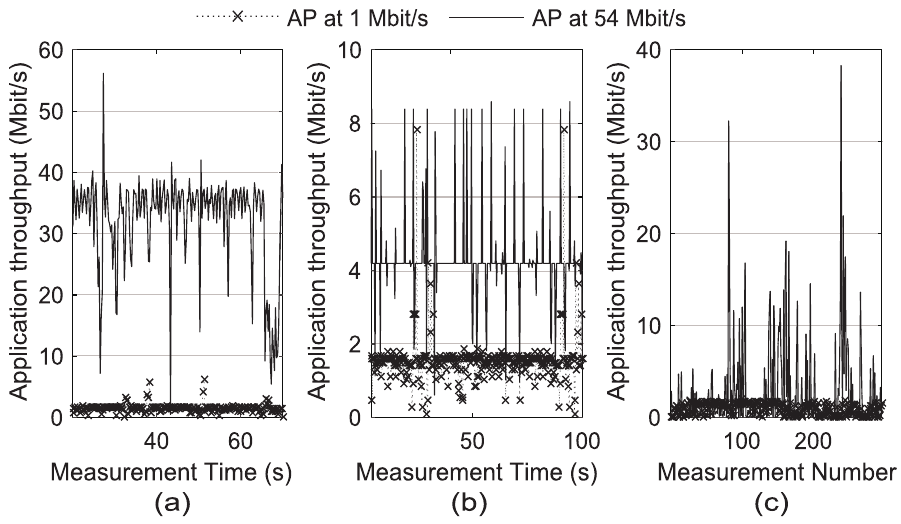
Fig 3. Throughput traces of the application packages. (a) the file download, (b) YouTube, and (c) the web browser, when the downlink bandwidth was configured to 1 and 54 Mbit/s.